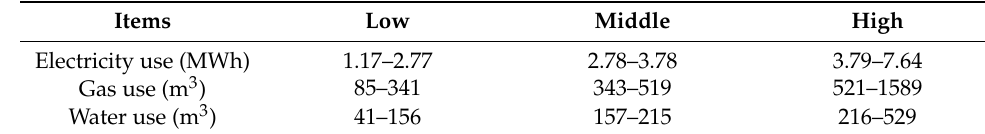
Figure 6. Relationship between the annual water use and the energy-saving effects of CGS in each household (n = 304): ( a ) generation; ( b ) contribution rate. Table 7. Three levels of annual electricity, gas, and water use in each household.